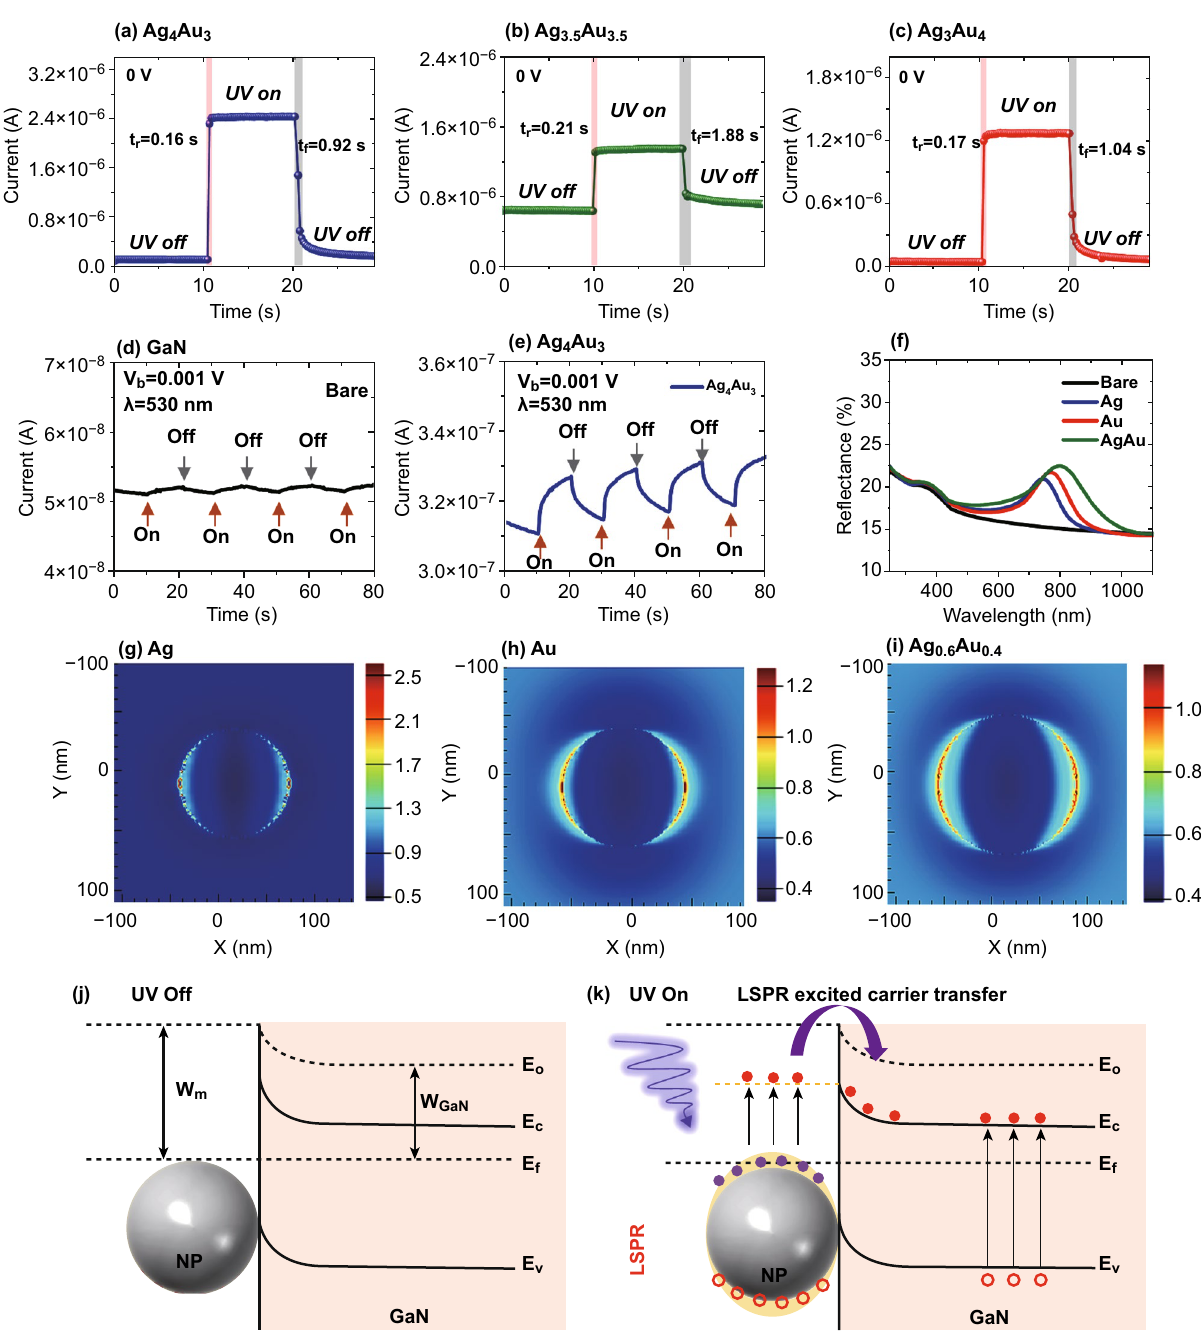
Fig. 6 a – c Photoresponse of the Ag 4 Au 3 , Ag 3.5 Au 3.5 , and Ag 3 Au 4 photodetectors under 385 nm UV illumination (10.36 mW mm −2 ) at 0 V. d , e I–t characteristic under the illumination of 530 nm at 1 mV for the bare GaN and Ag 4 Au 3 photodetectors. f FDTD simulated reflectance spectra of the typical Ag, Au and Ag 0.6 Au 0.4 alloy NPs. g – i Corresponding e‑field distribution of the typical NPs at 385 nm excitation. j – k Schematics of the energy band diagrams of the NP photodetector and the charge transfer process under UV